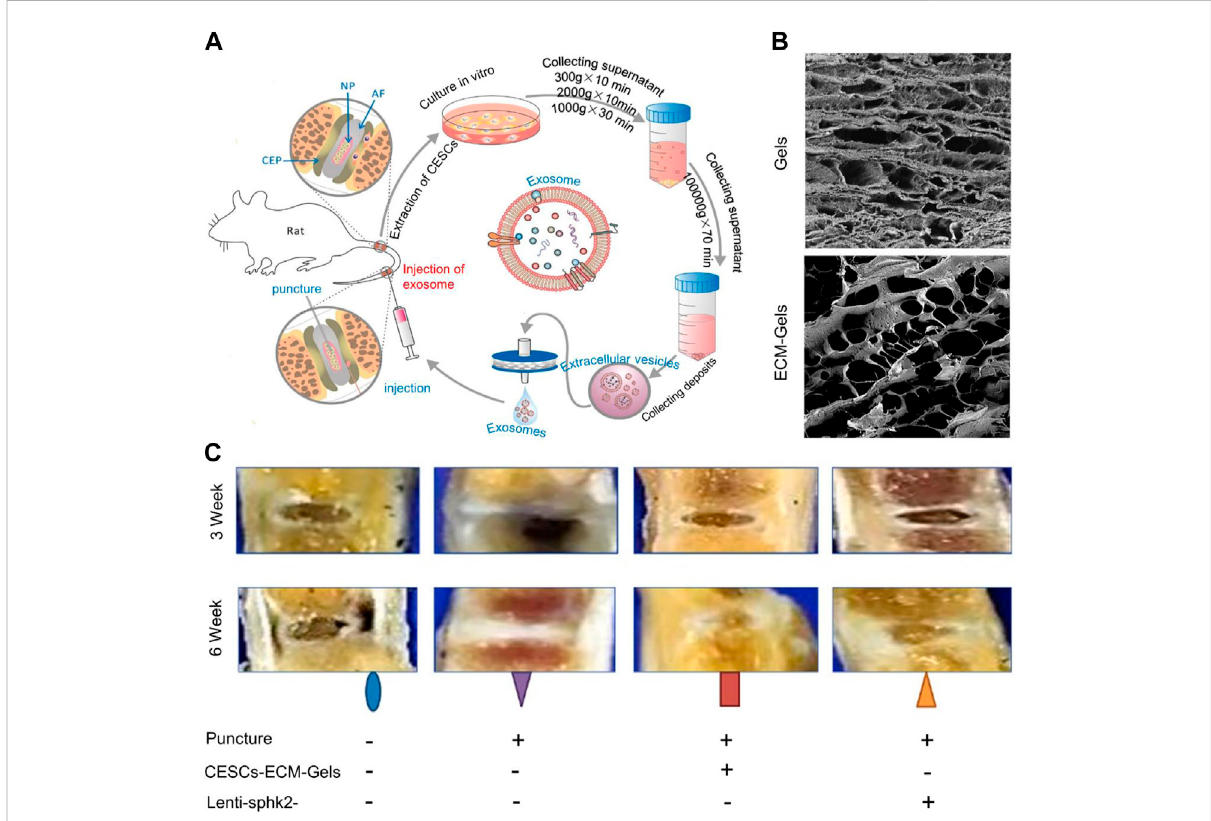
FIGURE 4 (A) Flowchart of exosome extraction and treatment of intervertebral disc degeneration (IVDD). (B) Scanning electron microscopy images of hydrogels with or without extracellular matrix (ECM) modi fi cation of costal cartilage. (C) Morphology of IVD tissue at 3 and 6 weeks after treatment with ECM gel and Lenti-Sphk2-extracellular vesicles (EVs) in the control group. Reproduced with permission from (Luo et al.,